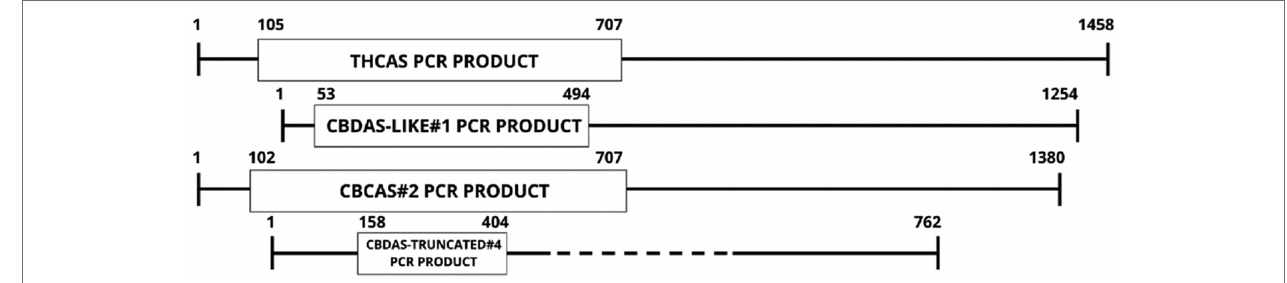
FIGURE 2 | Graphical representation of gene CDS alignments used for PCR amplification for siRNA